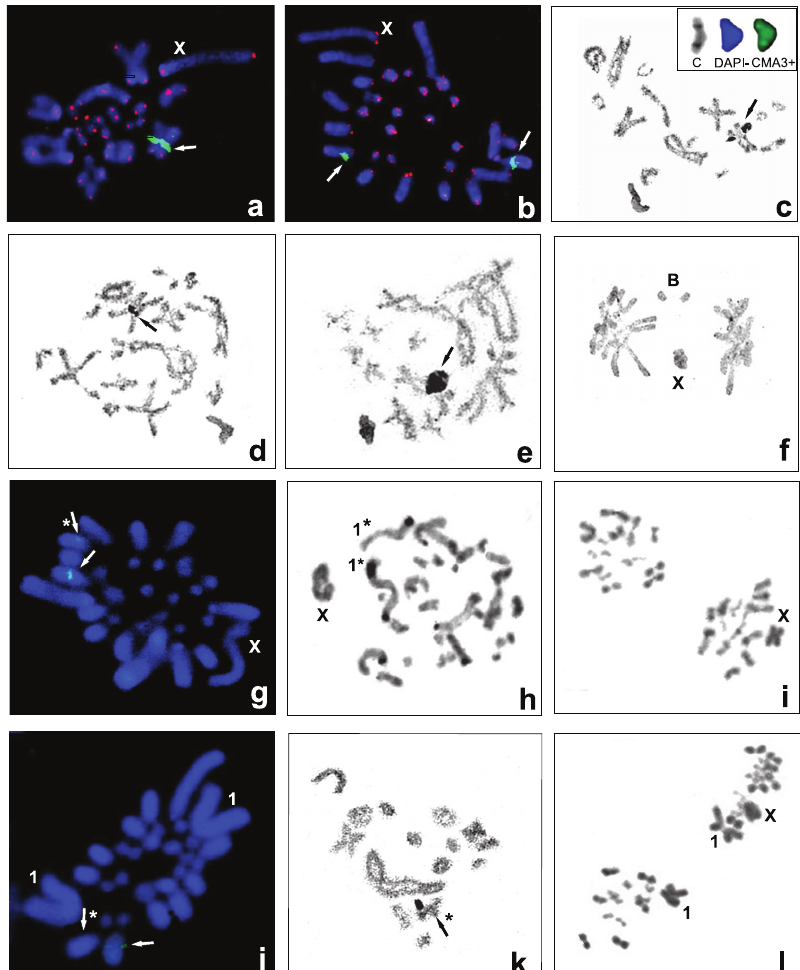
Figure 1. Examples of chromosome banding in different species of the tribes Eupholidoptera ( a–c ) and Parapholidoptera with 2n = 31 ( d–i ) and 2n = 29 ( j–l ) studied using different techniques. 18S rDNA FISH revealed a single interstitial cluster (per haploid genome) located in the 3/4 or 4/5 bivalent ( a, b, g, j ) and co-localized with the active NOR visualized by AgNO staining ( c–e, k ). a E. astyla, diakinesis and b E. 3 megastyla , spermatogonial metaphase with 18S rDNA loci (green, arrows) located close to the paracentro- meric region of bivalent 3/4 and telomeric DNA probes (red) c E. schmidti , diakinesis with NOR (arrow) and selected C+, DAPI- and CMA + bands located interstitially on 3/4 bivalent (in the right corner) d P. 3 cf. belen and e P. distincta , diplotene, arrows indicate NOR located in the middle of bivalent 3/4 f P. distincta , anaphase I with B chromosomes g, h, i P. grandis g spermatogonial metaphase with the rDNA cluster with different size between homologous chromosomes (arrows) h heterochromatin heteromor- phism in respect to the pattern of C-bands in the first autosome pair (1, asterisks) i two metaphase II with bi-armed X chromosome j, k, l P. aff. syriaca j spermatogonial metaphase, rDNA-FISH signal present/ absent in homologous chromosomes (arrows and an asterisk) correspond to k NOR l two metaphase II with bi-armed first pair of autosomes (1) and acrocentric X. Bar = 10